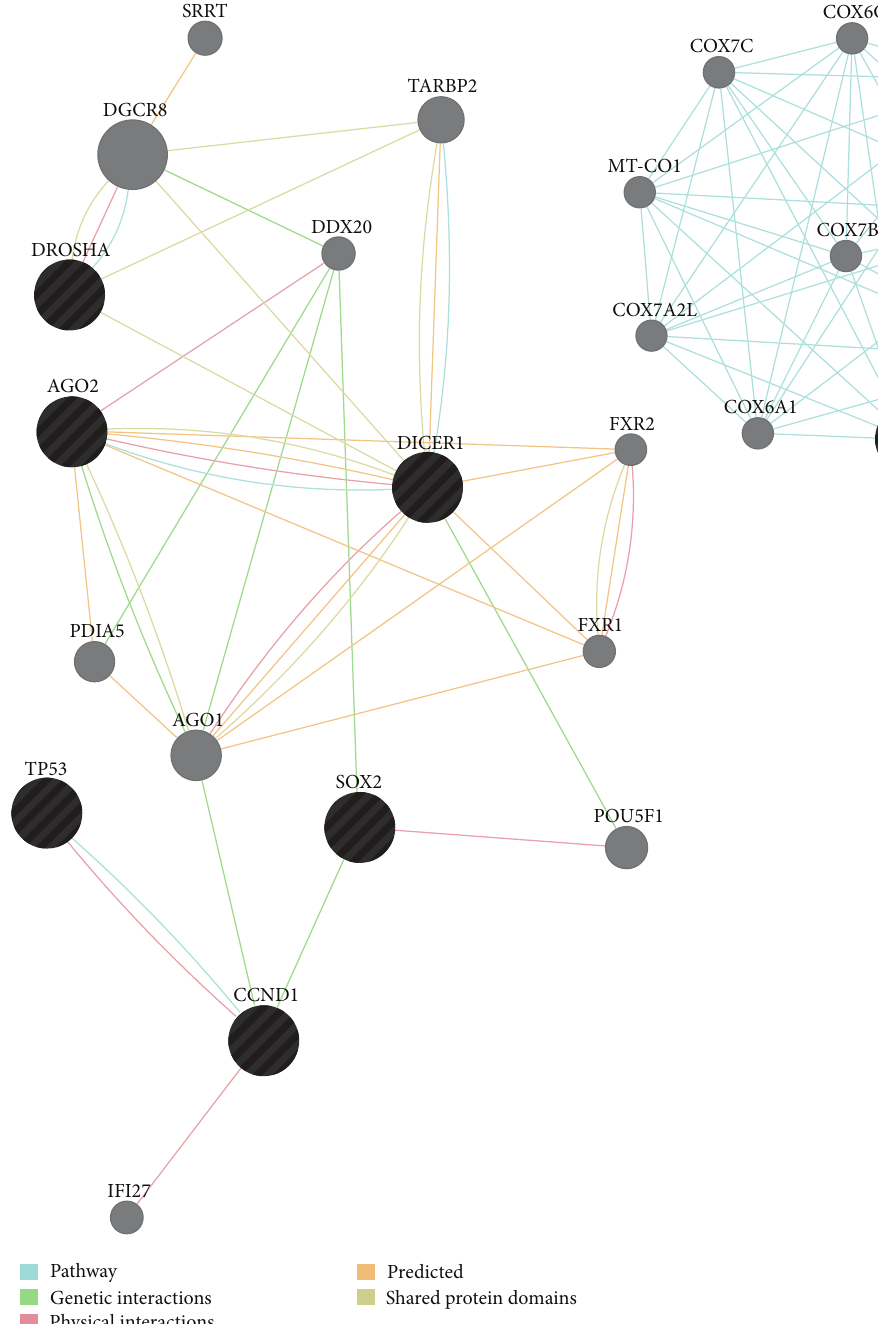
Figure 1: SOX2 ceRNA network by